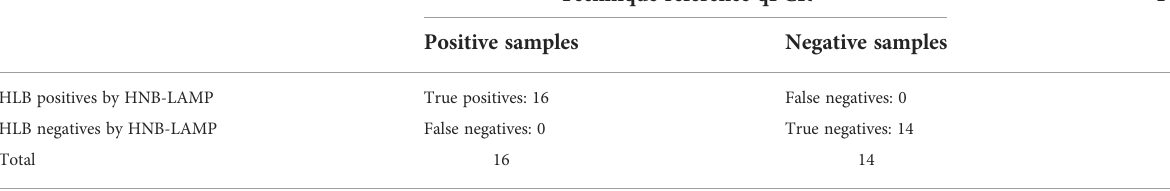
TABLE 1 Sensitivity and speci fi city of loop-mediated isothermal ampli fi cation (LAMP) methods in comparison with qPCR.